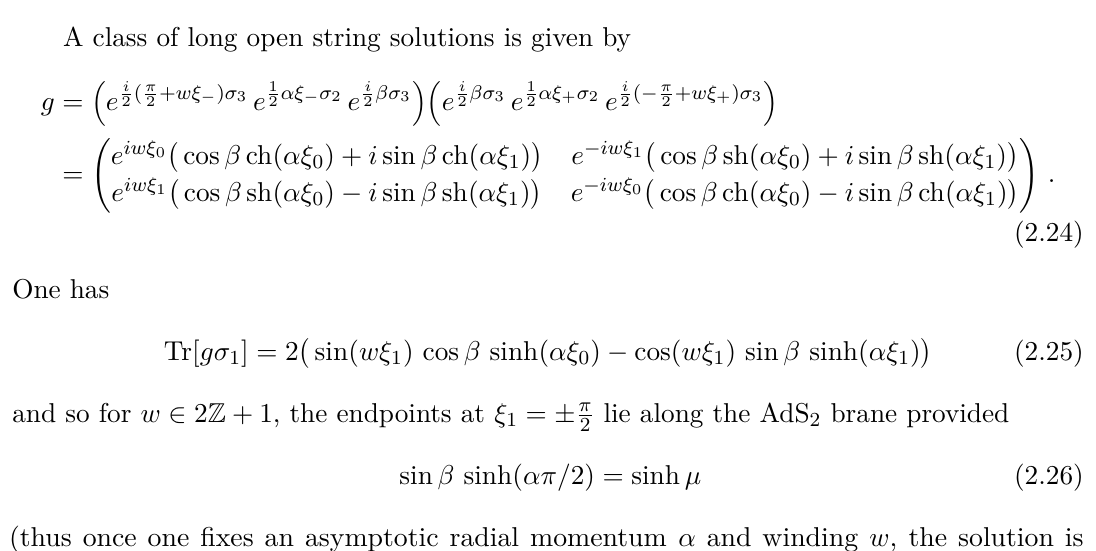
Figure 4. The primitive classical long open strings initially wind halfway around one side of AdS 3 in the far past, and end up winding halfway around the opposite side in the far